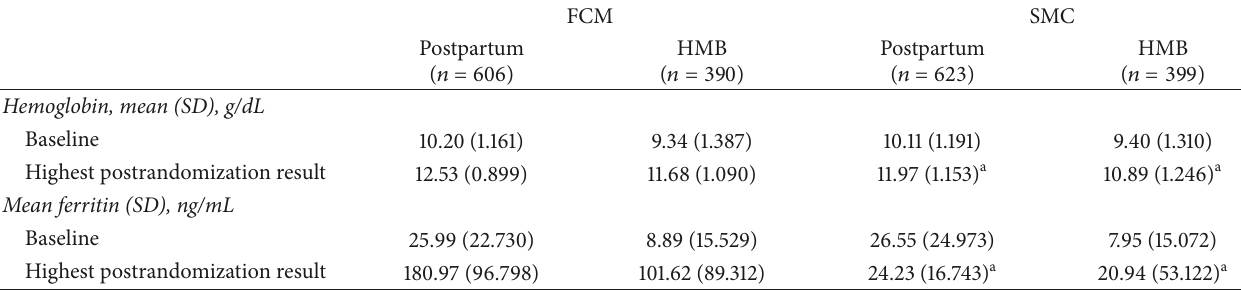
Table 5: Mean hemoglobin and ferritin levels at baseline and at the highest level after randomization (safety population).